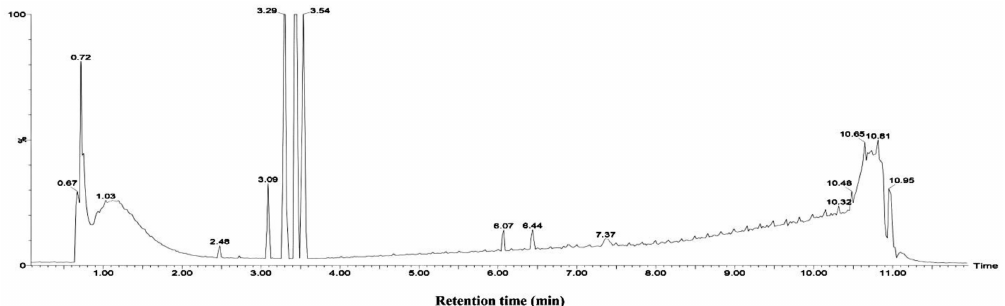
Figure 8. Identification of chemical constituents from sterilized artificial seawater in negative mode. Numbers above peaks represent retention times, in